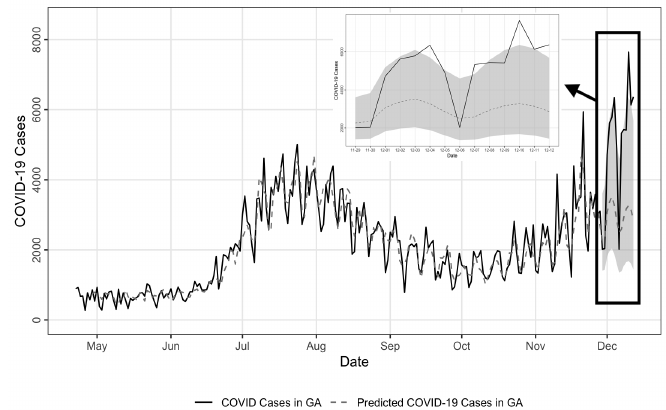
Figure 1. Epidemic curve of measured daily COVID-19 incident cases and C19Check-predicted COVID-19 cases from April 22– December 12, 2020 in the state of Georgia. The upper and lower confidence intervals (gray shading) from the fitted VAR model with a time-lag of seven days are depicted from November